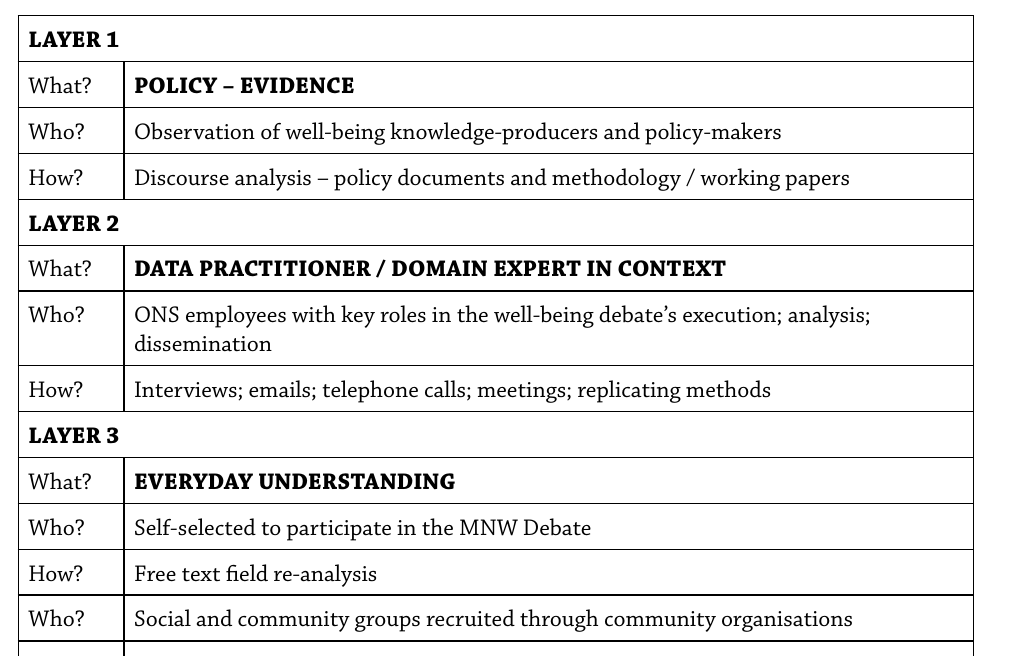
Table 2: Re-performance framework applied to a research design to capture a complex con- text of policy expertise: ONS’s MNW